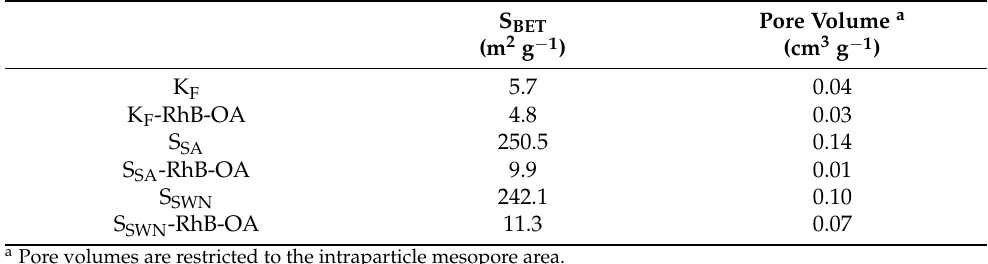
Figure 3. Nitrogen adsorption ( ○ )—desorption ( ● ) isotherms for all of the bare clays and final model gated organonanoclays. ( A ), K F and K F -RhB-OA; ( B ), S SA and S SA -RhB-OA; ( C ), S SWN and S SWN -RhB-OA. Table 2. BET specific surface values and pore volumes calculated from the N 2 adsorption-desorption isotherms for selected materials.